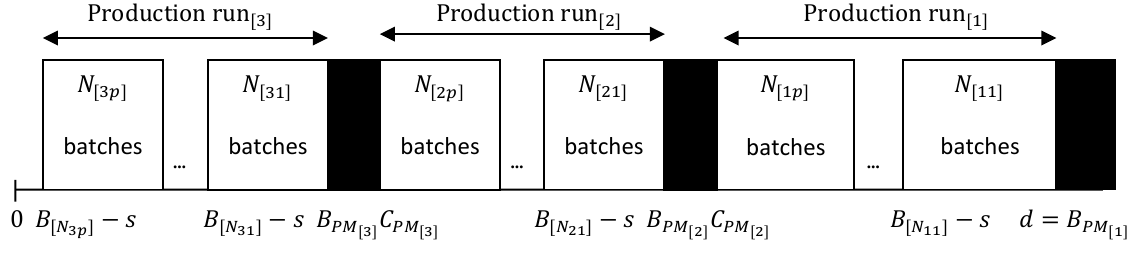
Fig. 3. Batches position in multiple items single machine